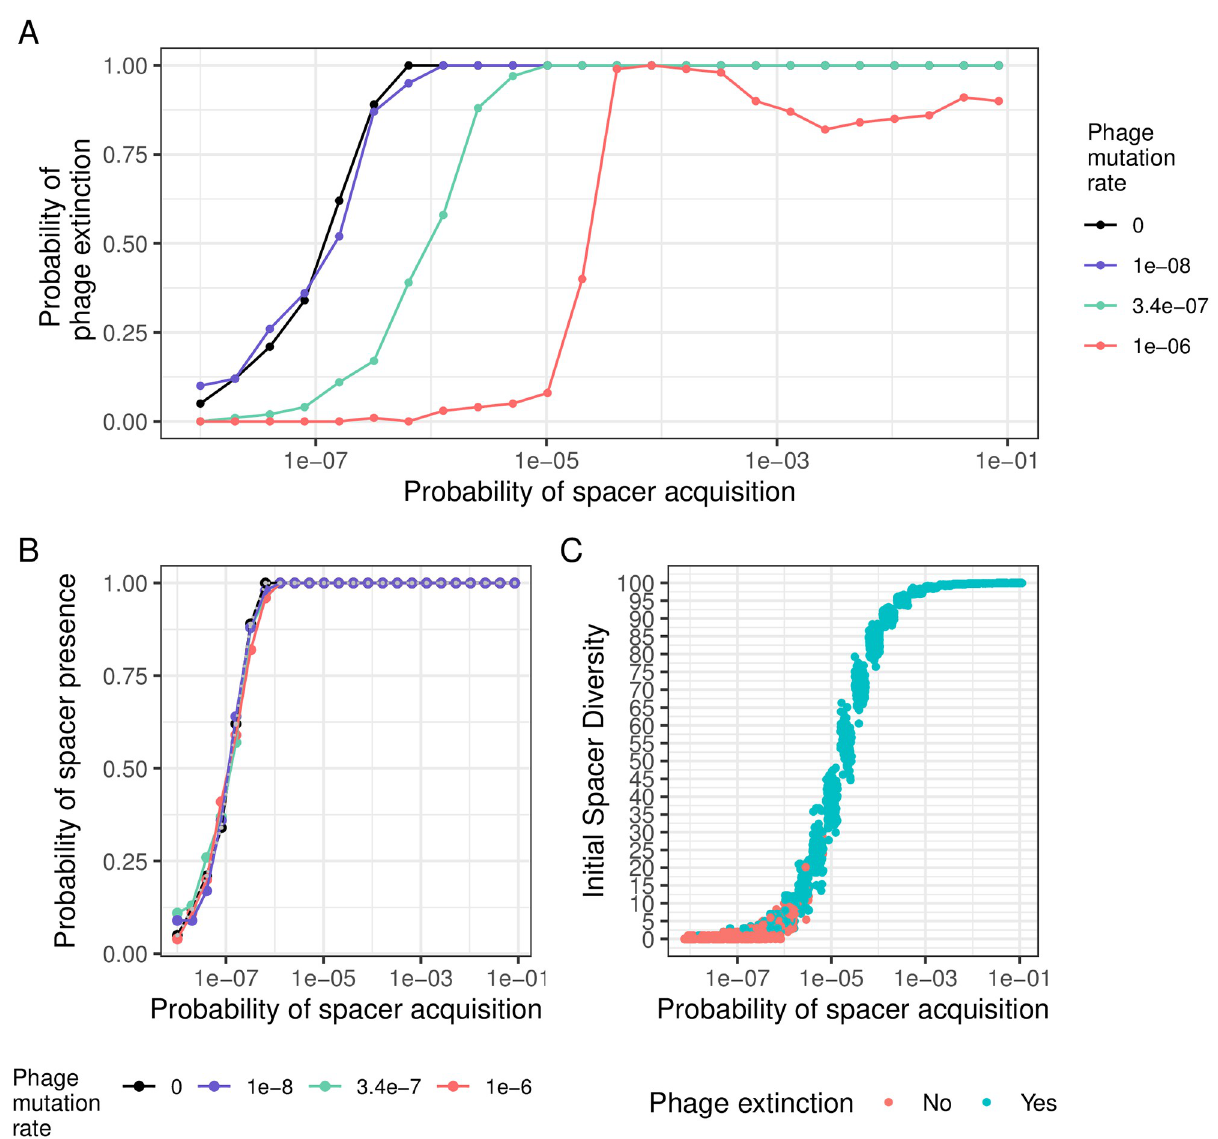
Fig 3. Influence of CRISPR-Cas probability of spacer acquisition on the probability of phage extinction in the absence of autoimmunity. A) Probability of phage survival when infecting bacteria with different acquisition probabilities. The different colours correspond to different levels of phage evolution ( μ ): black, no evolution (Type III CRISPR-Cas systems, μ = 0), purple ( μ = 10 − 8 ); green (Type I/II CRISPR-Cas systems, μ = 3.4 � 10 − 7 ) and red ( μ = 10 − 6 ). B) Probability for bacteria with different probability of spacer acquisition to generate at least one single resistant cell that is present when sensitive cells reach extinction. The different colours correspond to different levels of phage evolution ( μ ): in black, no evolution (Type III CRISPR-Cas systems, μ = 0), in purple ( μ = 10 − 8 ); in green (Type I/II CRISPR-Cas systems, μ = 3.4 � 10 − 7 ) and in red ( μ = 10 − 6 ). The grey line corresponds to the probability of phage extinction in the absence of phage evolution μ = 0. C) Relationship between CRISPR-Cas acquisition probability (x-axis), initial spacer diversity (when S reaches extinction) (y-axis) and phage extinction (color) for type I/II CRISPR-Cas systems ( μ = 3.4 � 10 − 7